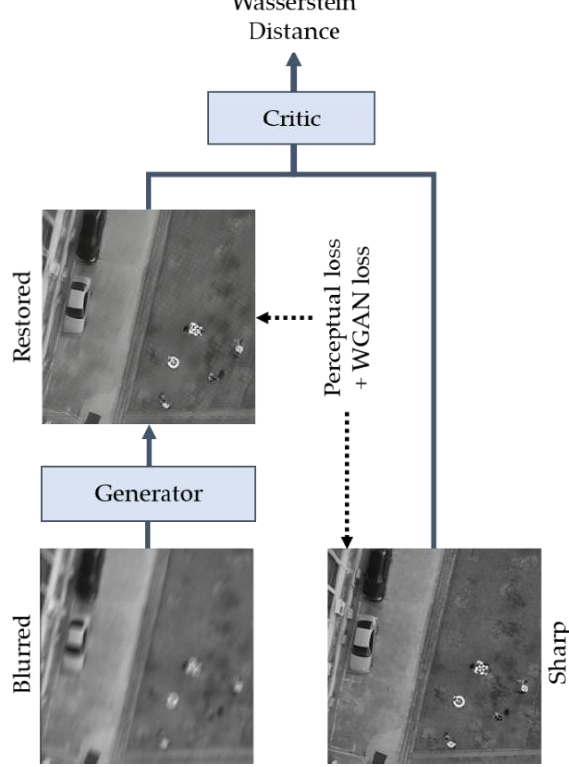
Figure 2. DeblurGAN architecture. The generator recovers the latent sharp image from the blurred image. The critic outputs the distance between the restored and sharp images. The total loss consists of perceptual loss and WGAN loss from the critic. After training and channel pruning, only the generator is used in Phase I.